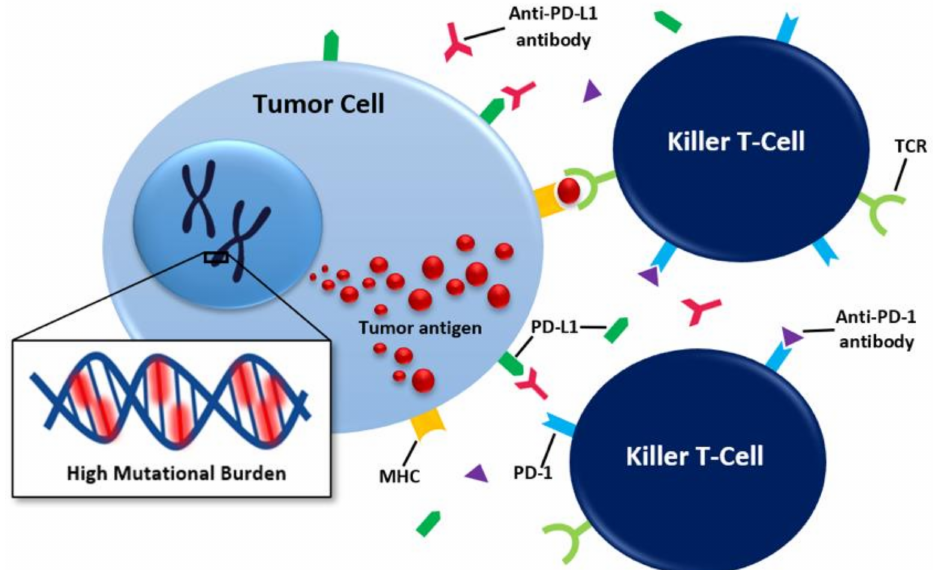
Figure 1. A brief review of the mechanism of action of PD-1/PD-L1 ICIs. Abbreviations: MHC, major histocompatibility complex; PD-1, programmed death-1; PD-L1, programmed death ligand-1; and TCR, T-cell